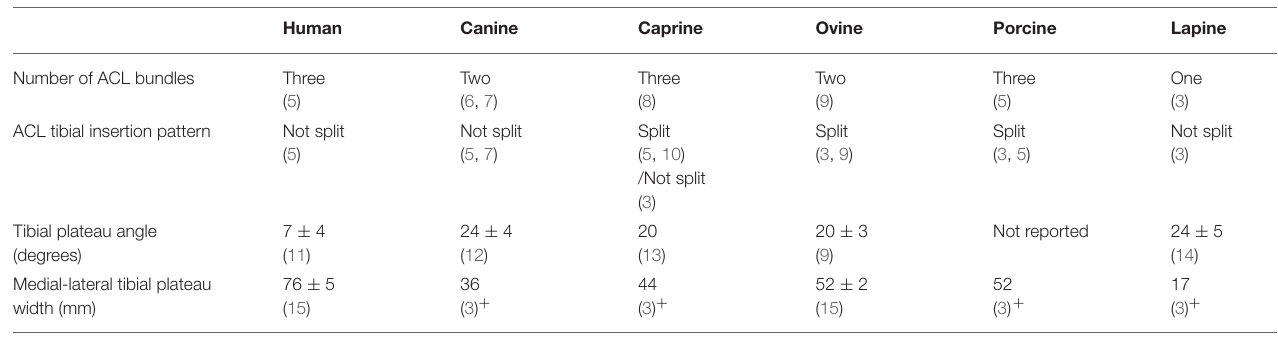
Human Canine Caprine Ovine Porcine